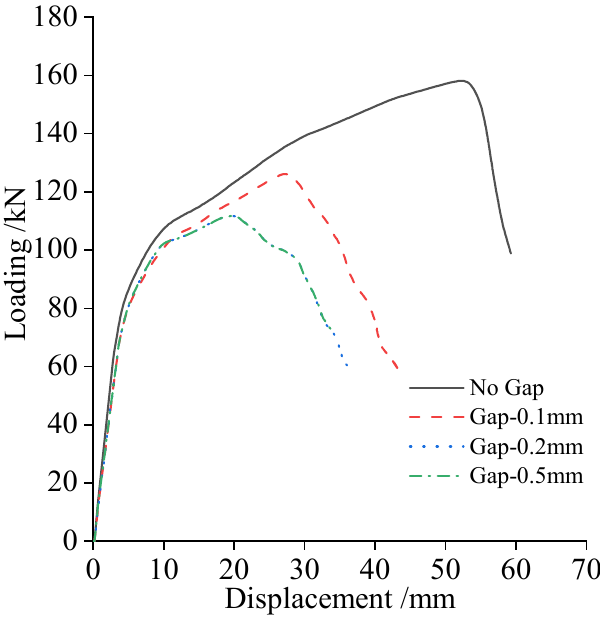
Figure 17. Load–Displacement curves of different gap distances. Figure 17. Load –Displacement curves of different gap distances.